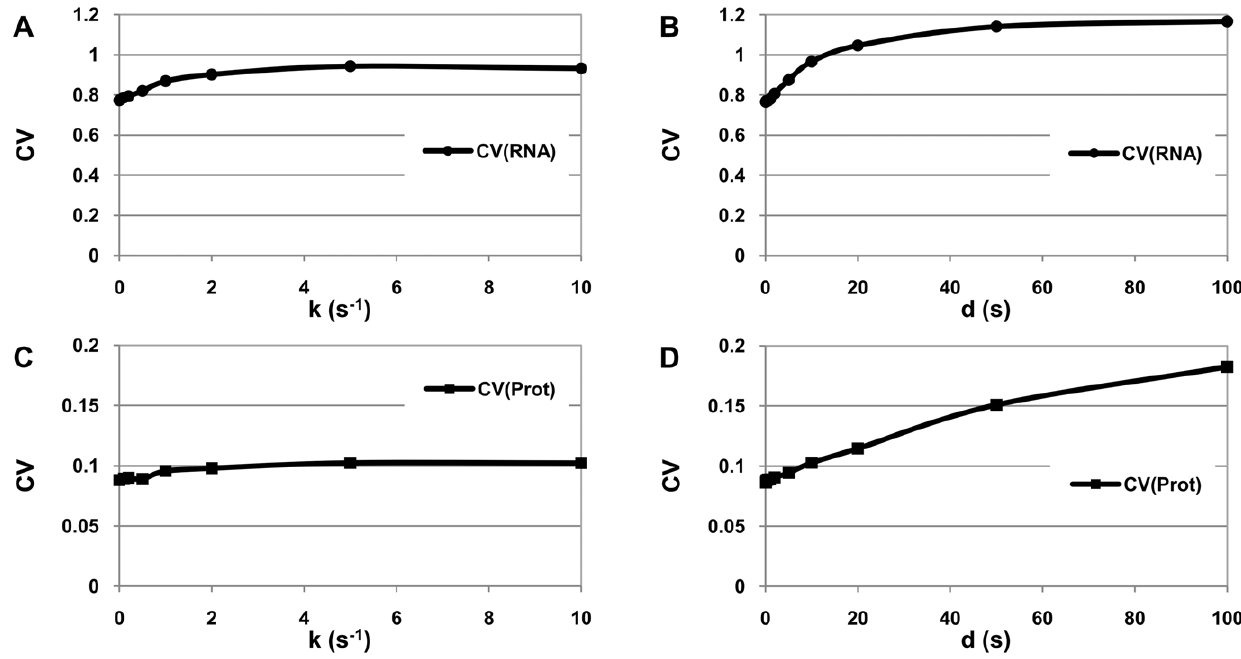
Figure 5. Noise of protein and RNA levels. CV (standard deviation over the mean) of RNA and protein levels at homeostasis measured for 50000 s, 1 s sampling frequency: (A) CV of RNA when varying pausing rate, (B) CV of RNA when varying pause duration, (C) CV of proteins when varying pausing rate, and (D) CV of proteins when varying pause duration. Note the different scales in the y-axis.